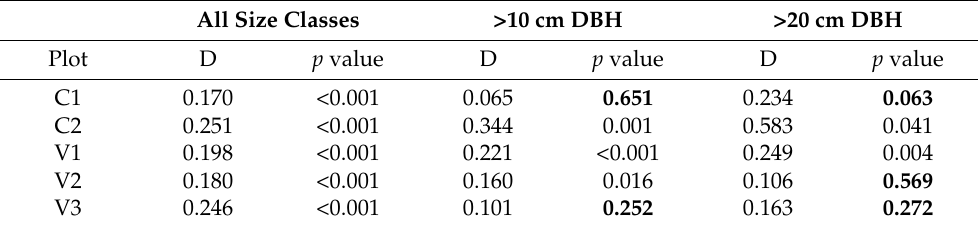
Table 3. Results of the plot level KS-tests comparing field-surveyed with UAV-LS modelled DBH. D represents the KS test statistic, and the p value is the p value result of the KS test. Bold p values show when there was no significant difference between field measured and UAV-LS modelled diameter distributions. All Size Classes >10 cm DBH >20 cm DBH Plot D p value D p value D p value C1 0.170 <0.001 0.065 0.651 0.234 0.063 C2 0.251 <0.001 0.344 0.001 0.583 0.041 V1 0.198 <0.001 0.221 <0.001 0.249 0.004 V2 0.180 <0.001 0.160 0.016 0.106 0.569 V3 0.246 <0.001 0.101 0.252 0.163